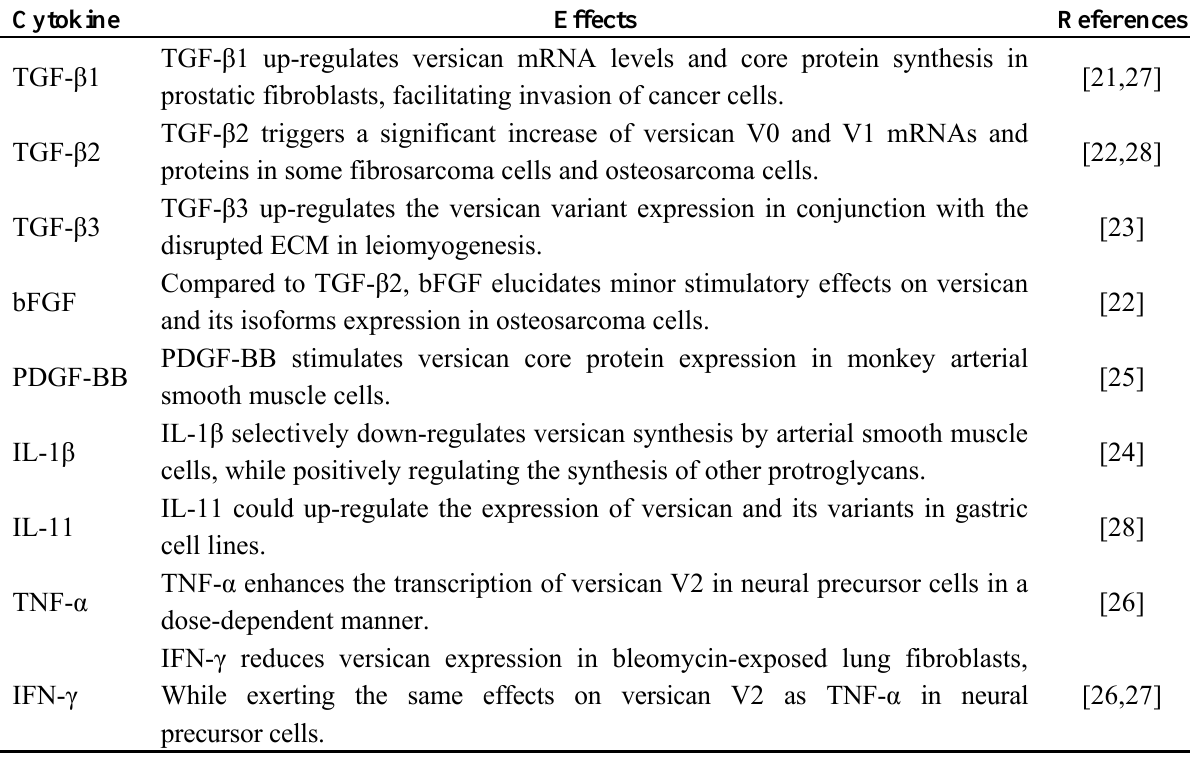
Table 1. Summary of cytokine effects on